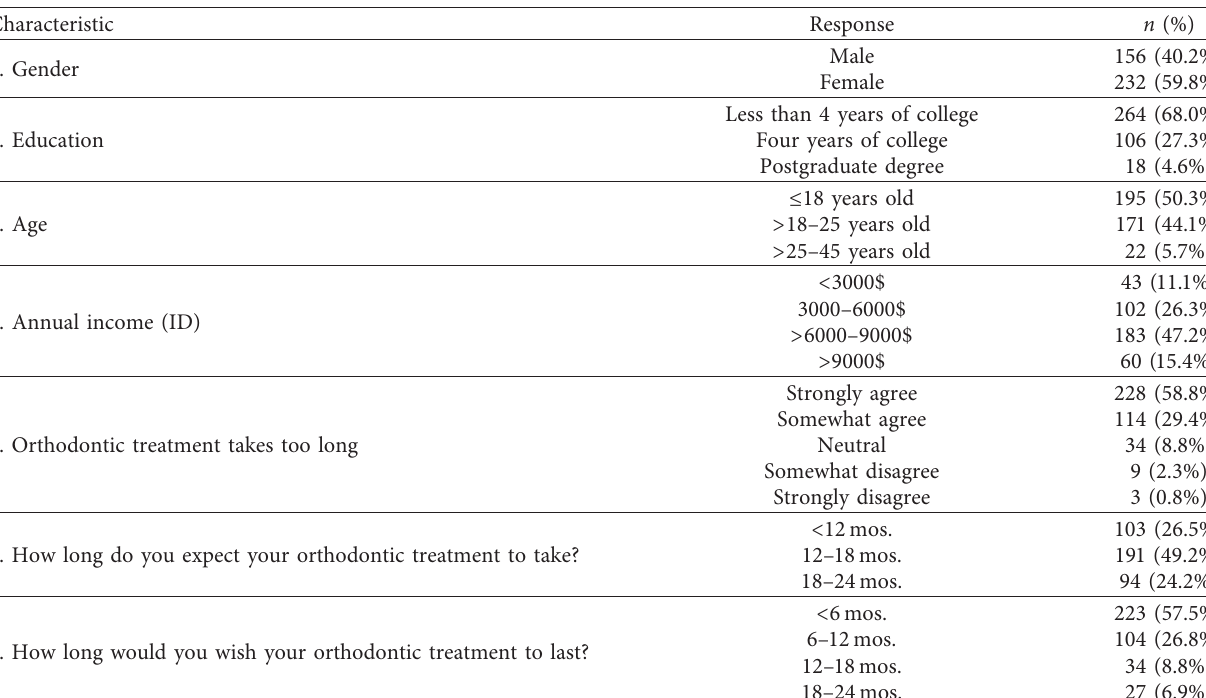
Table 2: Characteristics of the patients participating in the study.